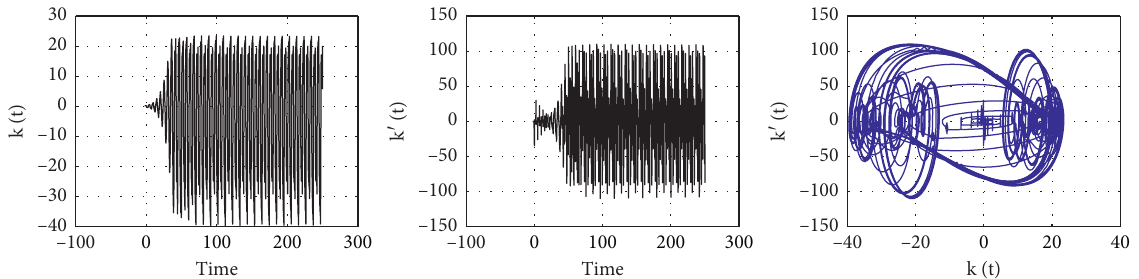
Figure 9: Solutions and phase trajectories at a � 0.125, q � 0.25, and τ � 2.5.